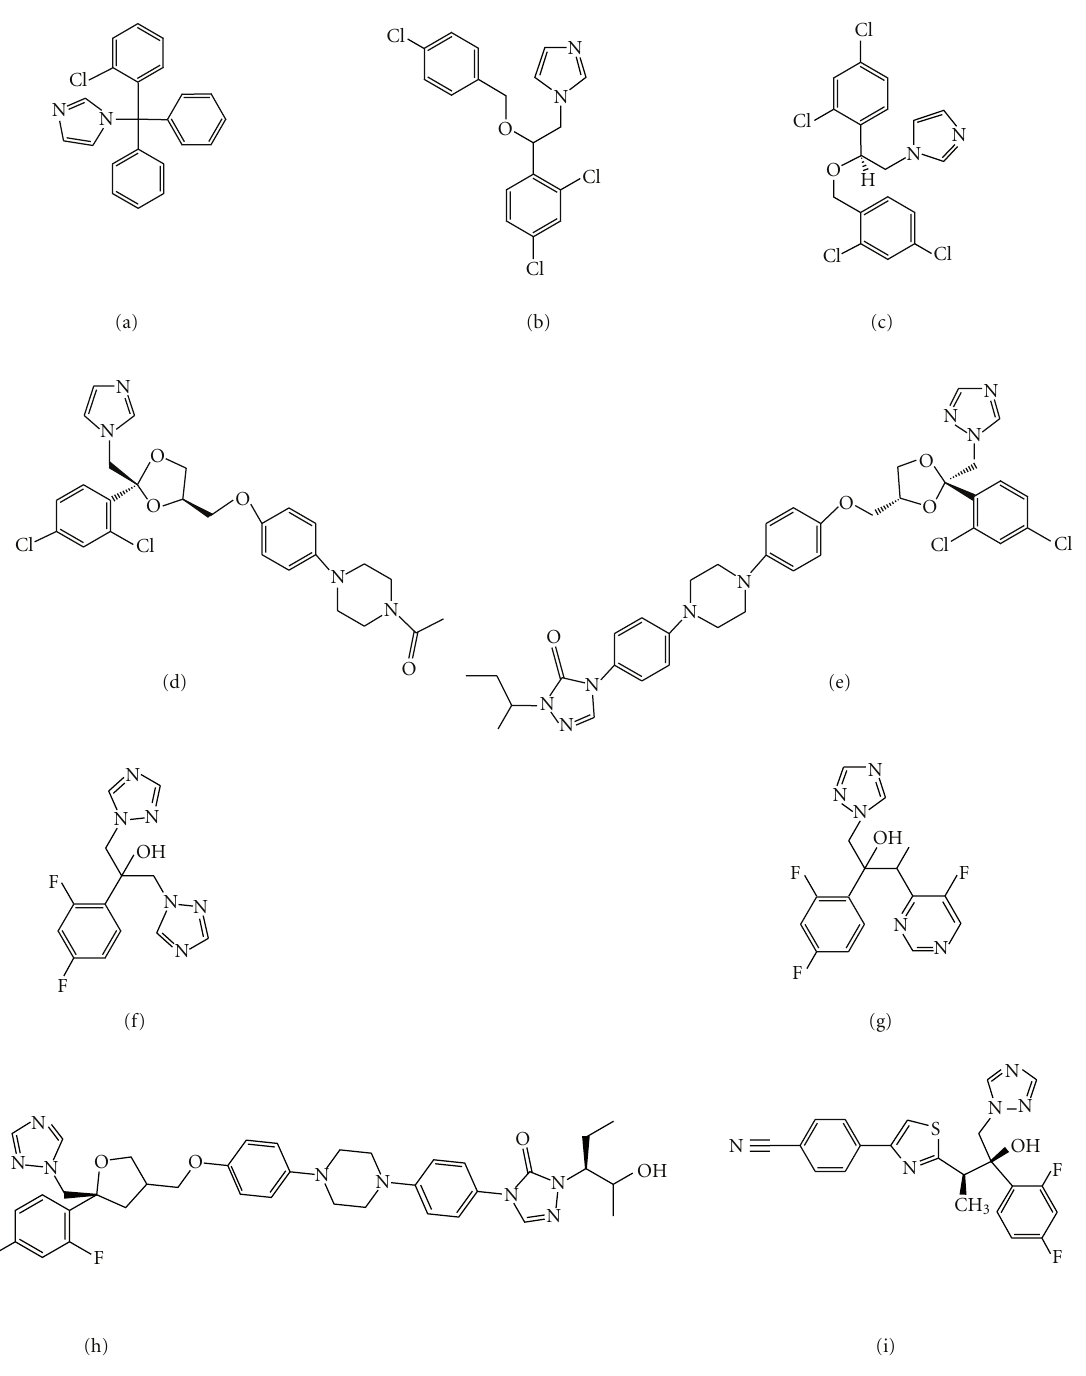
Figure 5: Chemical structures of the main azole antifungals, four imidazoles: clotrimazole (a), econazole (b), miconazole (c), and ketoconazole (d), two triazoles: itraconazole (e) and fluconazole (f), and three new generation triazoles: voriconazole (g), posaconazole (h), and ravuconazole